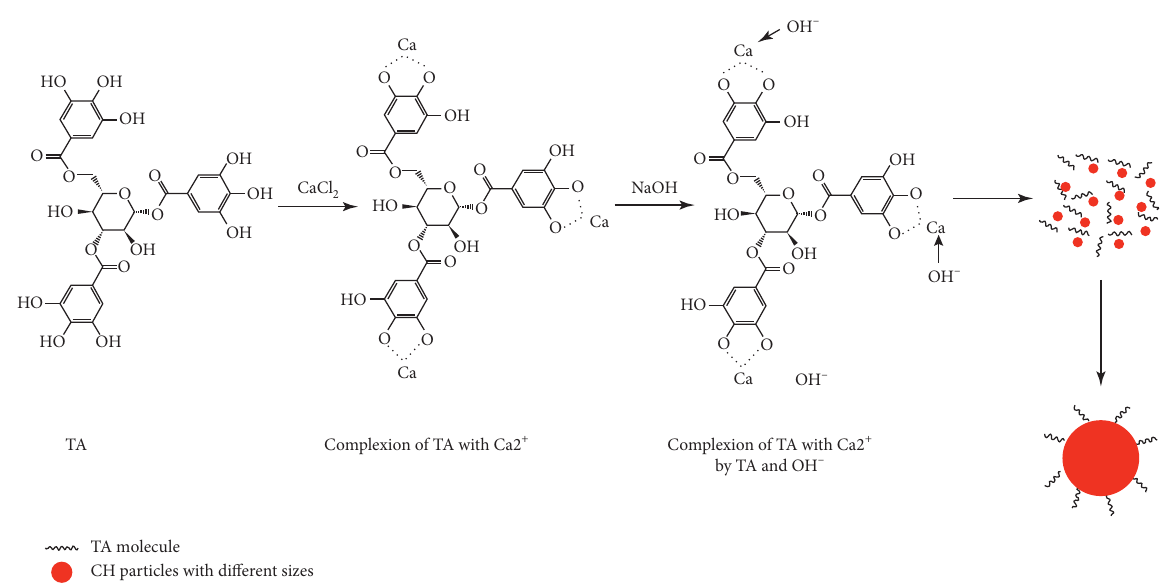
Figure 5: Schematic of the formation of CH nanoparticles with the assistant of